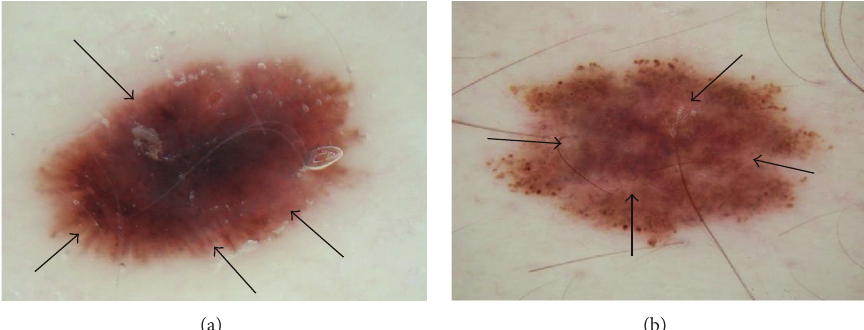
Figure5:(a)Invasivemelanoma,5 mmwide,lateralabdomen,32-year-oldmale,0.44 mmthick,peripheralpink,withpinkrimsign(arrows). (b) Enlarging melanocytic lesion with congenital features, 8 mm wide, abdomen, 21-year-old male. Pink is more prominent centrally than peripherally, negative pink rim sign.